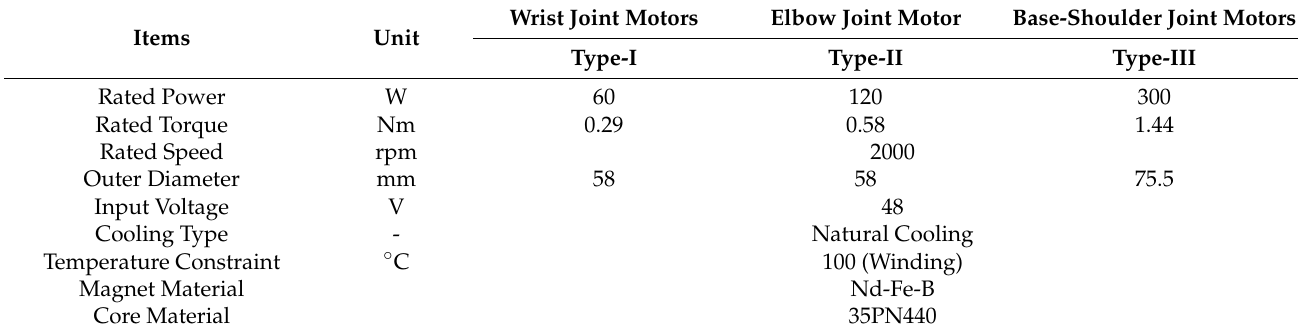
Table 4. Design Requirements of Joint Motors.